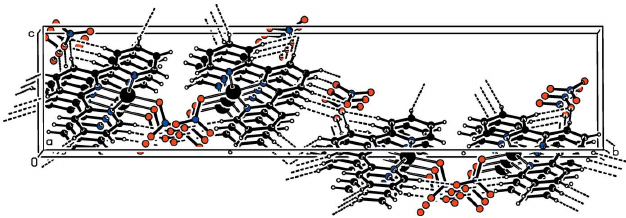
Figure 2 A view of the packing in the crystal of the title complex, viewed approximately along the a axis. Hydrogen-bonding interactions are drawn as dashed